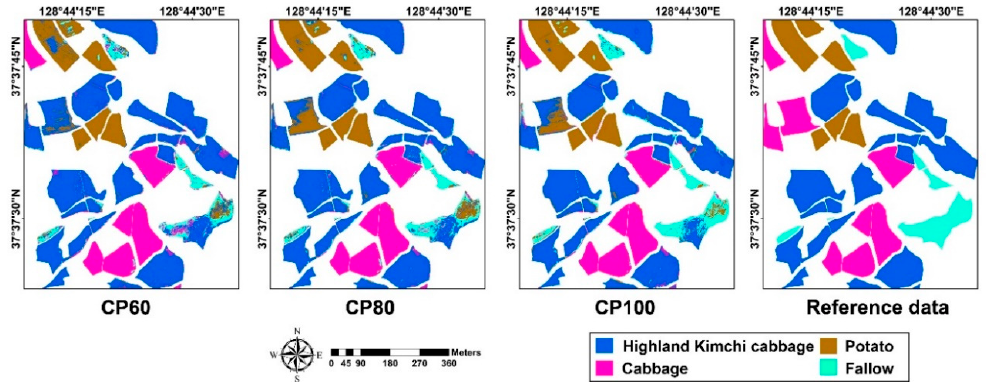
Figure 7. Classification results with respect to different class purity values when using a 9 by 9 patch in Anbandegi.